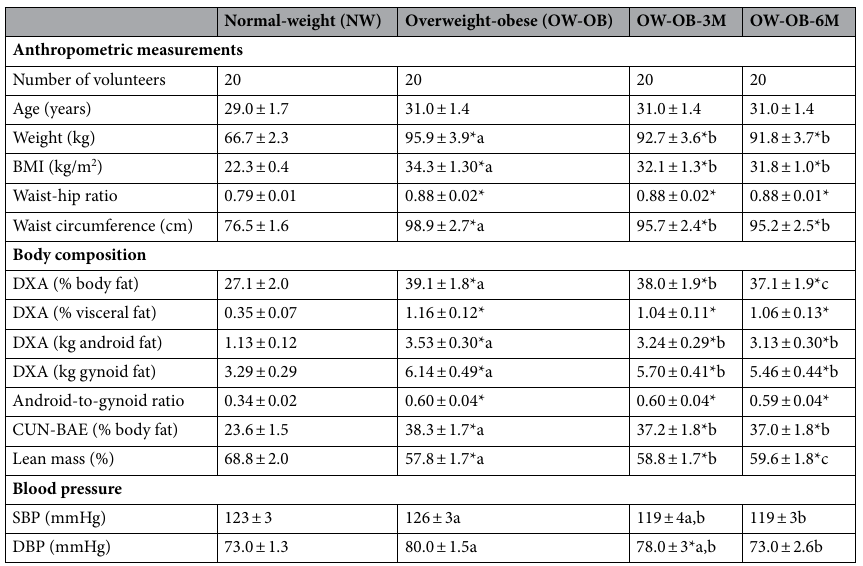
Table 3. Anthropometric data, body composition and blood pressure in overweight-obese participants that completed the 6-month intervention. Data are mean ± SEM (n = 20 in the NW and n = 20 in the different OW-OB groups). Statistics: within the OW-OB groups, values not sharing a common letter (a, b) are significantly different (repeated measures ANOVA, p < 0.05); no letter indicates no significant differences; *indicates values significantly different vs NW group (Student’s t test, p < 0.05).